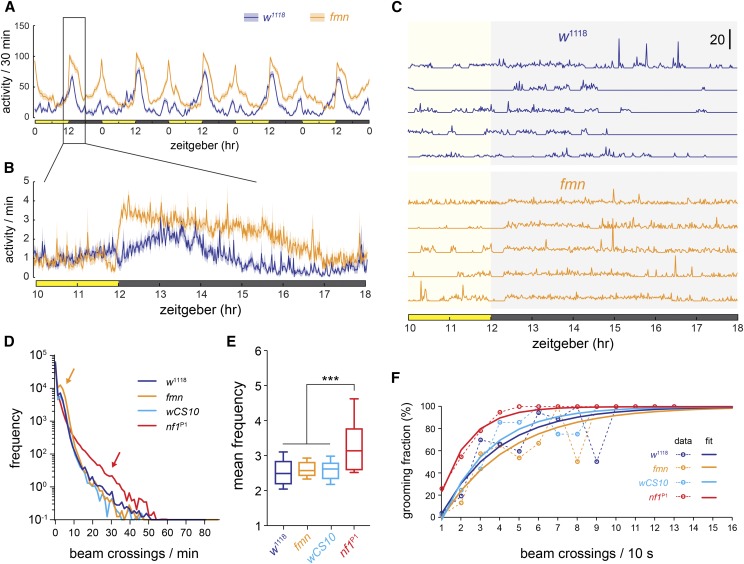
Activity profiles of nf1P1 mutants differ from the hyperactive fmn mutants. nf1P1 mutants exhibited in increases in high-frequency beam crossing (grooming), while fmn mutants exhibited increases in low-frequency beam crossing. (A) Group activity data from fmn mutants, in units of beam counts per 30 min bin. Lines and error bars represent mean ± SEM. (B) Group activity data of fmn mutants from a 6 hr window in units of beam counts per 1 min bin. (C) Representative examples of activity traces from individual flies sampled from the group data in (B). (D) Histogram of activity of fmn and nf1P1 mutants, with respective wild-type controls. All genotypes were run simultaneously (the nf1P1 and wCS10 groups are independent of the data shown in Figure 1 and Figure 2). Note the log scale. Arrows highlight the distinct patterns of fmn (orange) and nf1P1 (red) activity profiles. (E) Mean frequency (mean of nonzero values recorded by the infrared activity monitor). *** P < 0.001 (ANOVA/Tukey). (F) Mean proportion of grooming events scored from 24 hr videos, graphed against beam crossing frequency for each genotype (n = 4 per genotype). Mean values are fitted with a bounded exponential curve. The relatively high fluctuation at higher frequencies is due to low numbers of these events in controls and fmn flies (e.g., there were only two data points at eight and nine beam crossings for fmn and w1118, respectively; one of each was grooming). The nf1P1 data are from the same flies as graphed in Figure 3E.